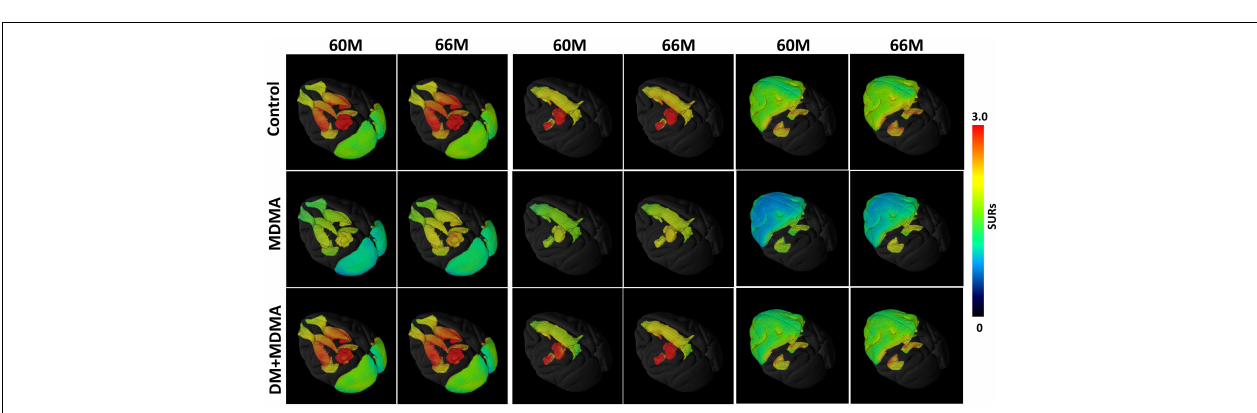
FIGURE 2 | 3D 4-[ 18 F]-ADAM PET images. Illustration of the location of the brain regions was used to estimate the SERT binding of 4-[ 18 F]-ADAM.